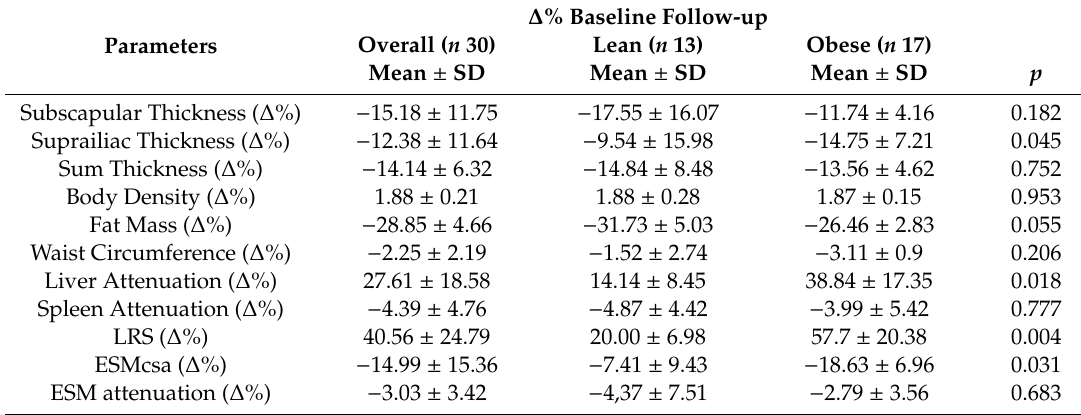
Table 3. Percentage change presentation and di ff erence between groups. ∆ % Baseline